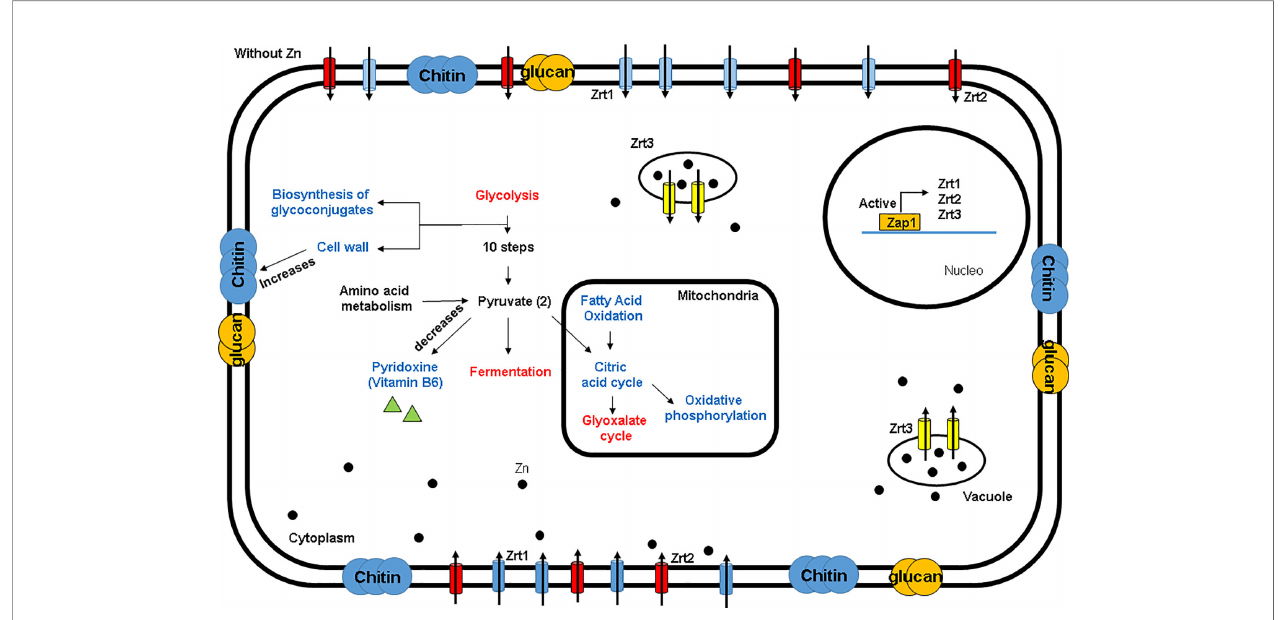
FIGURE 9 | Hypothetical model of H. capsulatum response to zinc